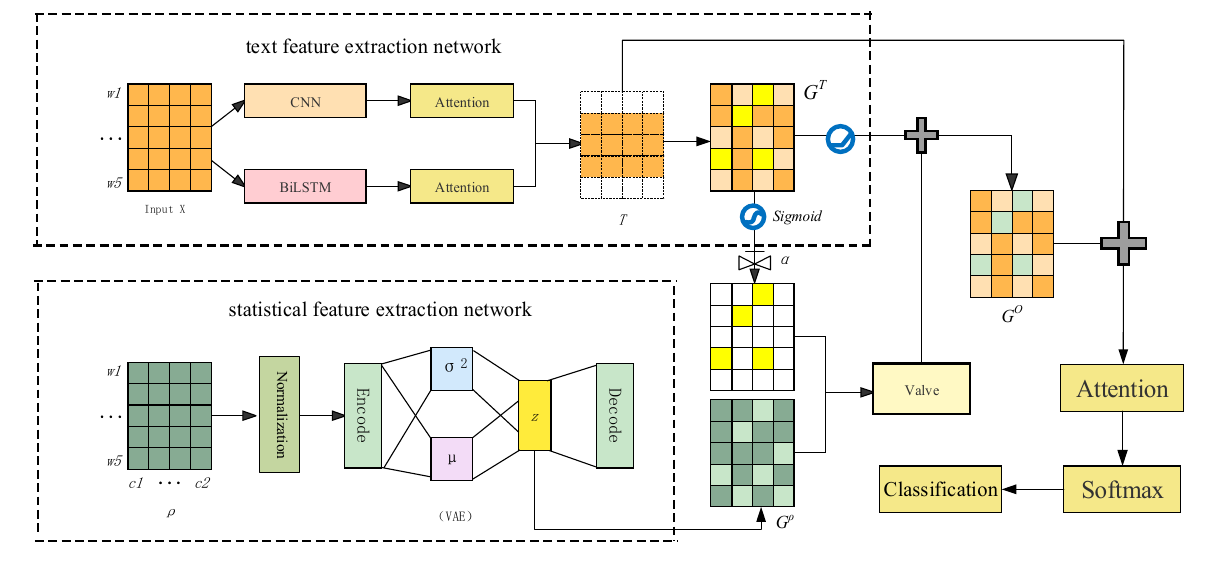
Figure 1. Overall model structure.